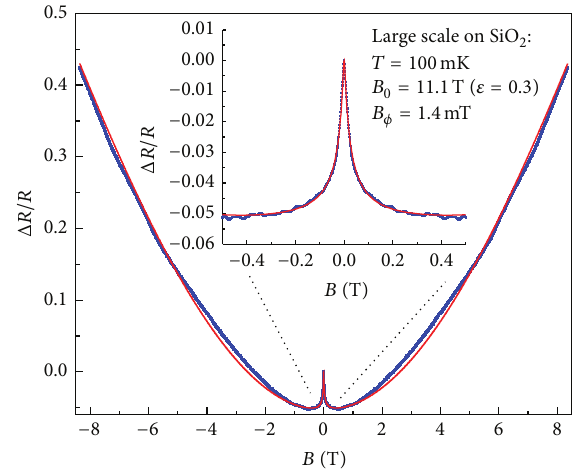
Figure 6: The measured magnetoresistance of a largescale graphene sample on SiO 2 /Si (blue dots). The symmetrized (𝑅 𝑥𝑥 (𝐵)+𝑅 𝑥𝑥 (−𝐵)) relative resistance and the fit (red line) using (19) with fitting parameters 𝐵 𝑐𝜙 = 1.4 mT, 𝐿 𝜙 /𝐿 𝑐 = 0.055 , 𝐵 0 = 11.1 T, 𝐵 𝑒 = 11 mT, and 𝐵 1 = 20.3 T and a zoom-in of the low field part in the inset are shown.